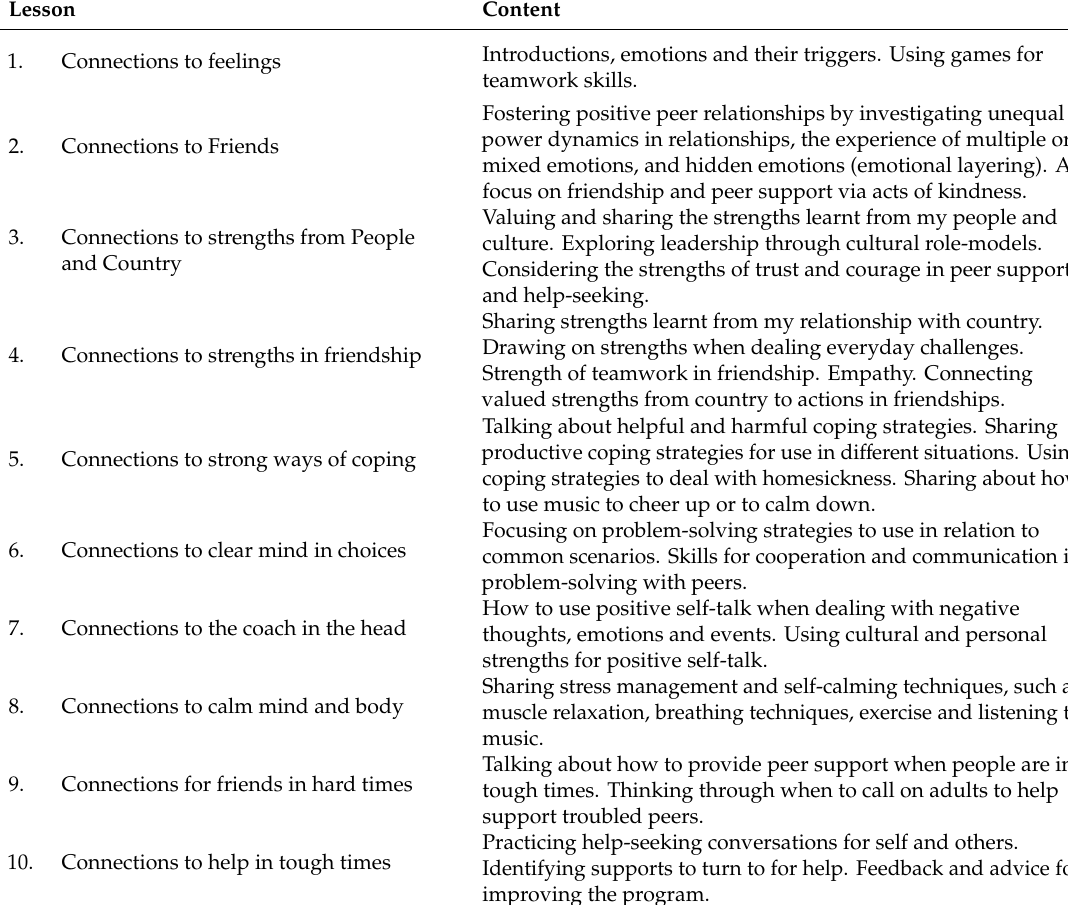
Table 1. Overview of the ‘Making Connections’ program